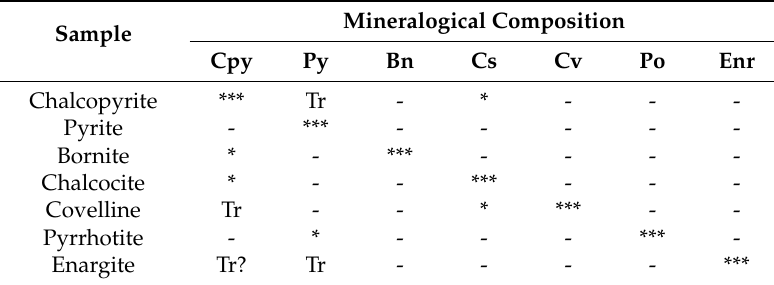
Table 2. Qualitative results by X-ray di ff